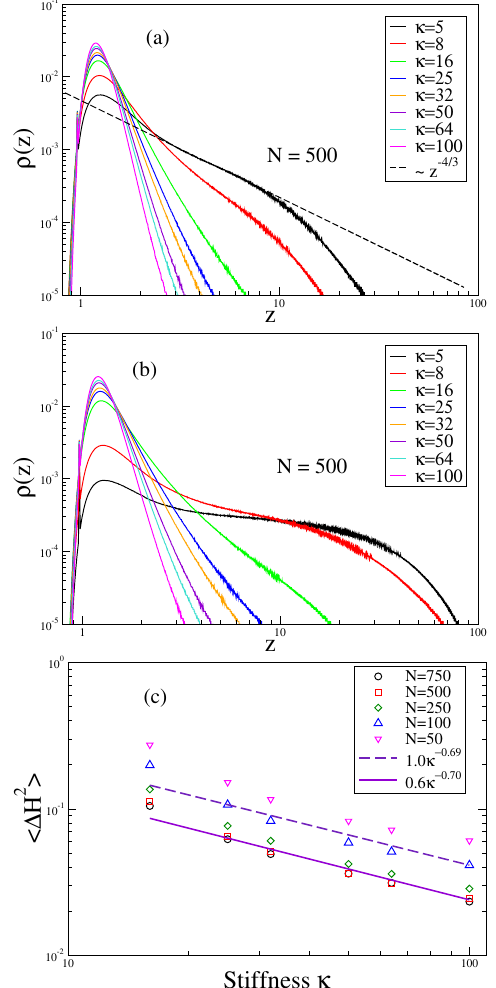
Figure 12. Density distribution function ρ ( z ) vs. z for several choices of κ for N = 500 and (cid:101) wall = 0.8 ( a ) and (cid:101) wall = 0.65 ( b ); For κ = 5, the predicted decay proportional to − 4/3 is seen; ( c ) log-log plot of the mean square width (cid:104) ∆ H 2 (cid:105) of the density distribution versus stiffness κ , at (cid:101) wall = 1.0 and five choices of the chain length N . Tentative phenomenological power law fits are indicated by a full straight line and a broken straight line as explained in the